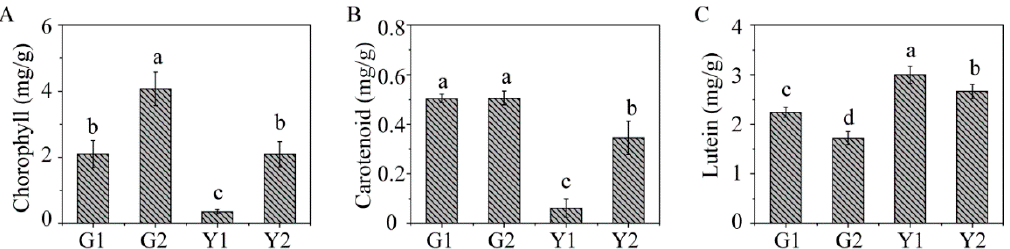
Figure 2. The measurement of pigment contents. ( A ) The level of chlorophyll; ( B ) The level of carotenoid; ( C ) The level of lutein. The values are shown as the means ± SD ( n ≥ 4), a – c indicate that the differences are significant at p < 0.05 (one-way ANOVA).